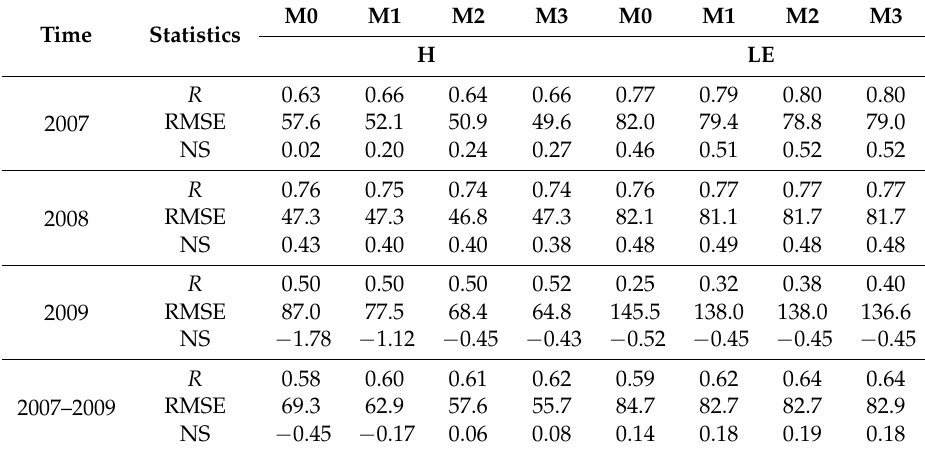
Table 2. Comparison of the latent (LE) and sensible (H) heat flux simulation accuracies among different optimized RWU parameterization